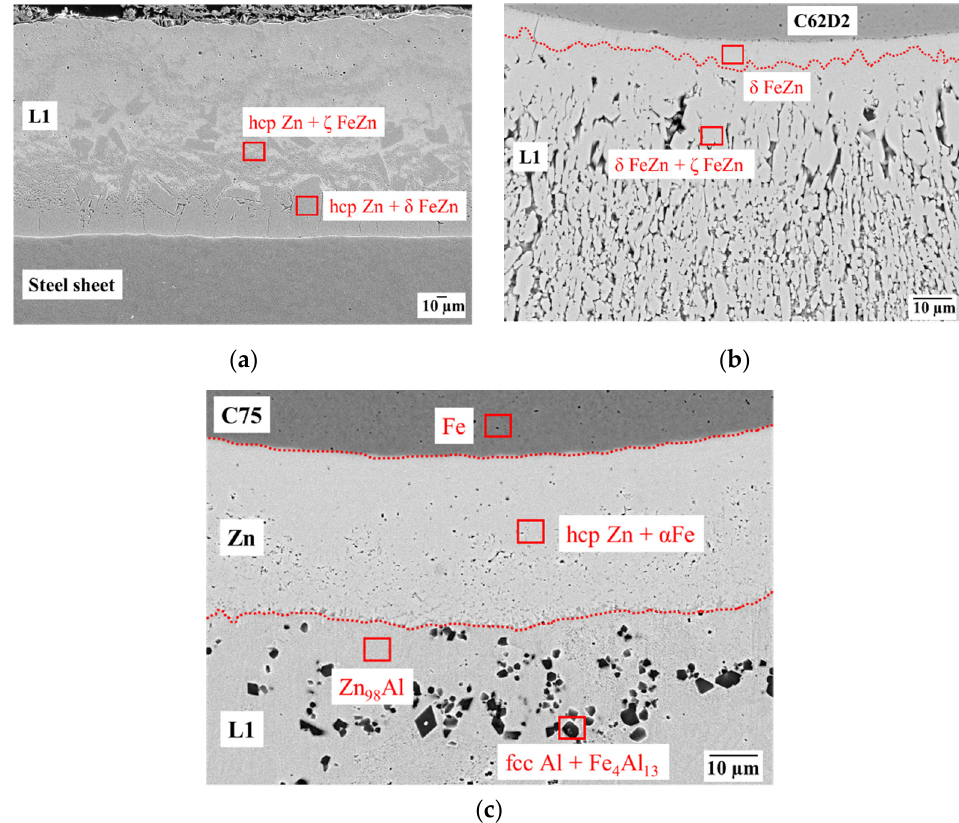
Figure 10. EDX phase analyses on the interphase of ( a ) C62D2-L1, ( b ) L1–Steel sheet, and ( c ) C75-Zn coating–L1 regions.